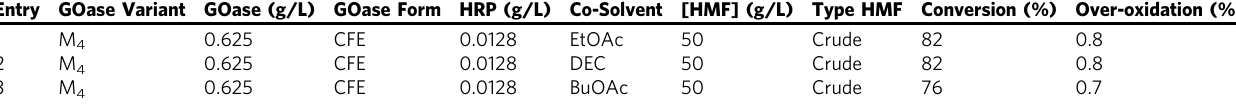
Data for reactions with puri fi ed enzyme provided in Supplementary Table 11. Conditions listed in the table highlight the main differences between samples, while those listed below the table apply to all entries unless otherwise stated.